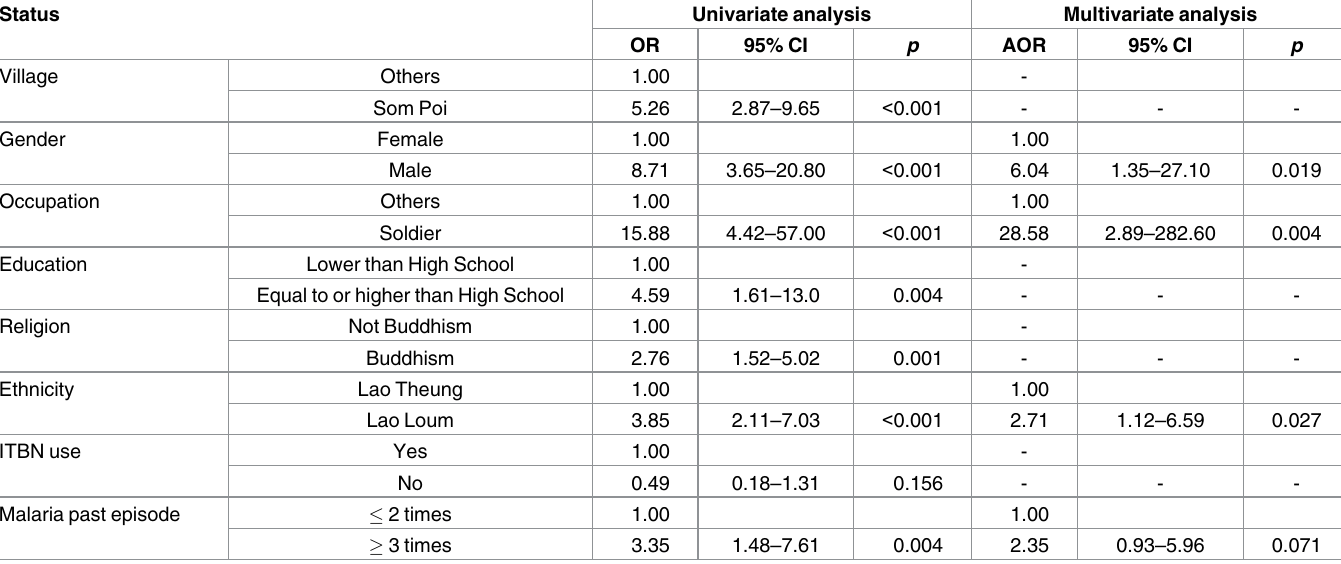
Table 5. Multivariate logistic regression analysesto identify risk factors for Plasmodium